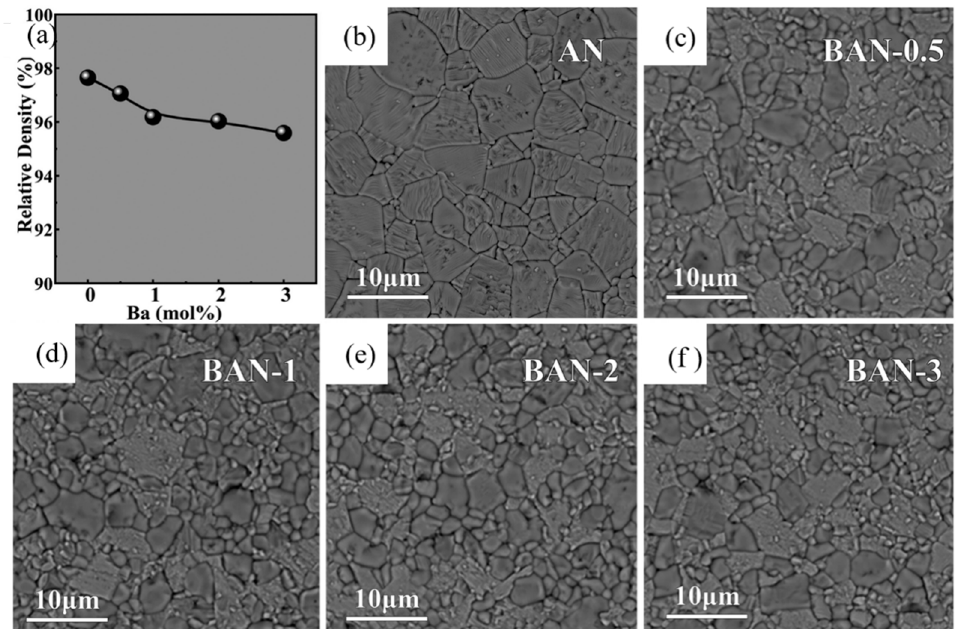
Figure 12. ( a ) The variation of relative density for the as-prepared Ba x% Ag 1-2x% NbO 3 (BAN- x ) ceramics, SEM images of ( b ) AN, ( c ) BAN-0.5, ( d ) BAN-1, ( e ) BAN-2 and ( f ) BAN-3 ceramics. Reprinted with permission from [74]. Copyright 2018 Elsevier Ltd. and Techna Group S.r.l.